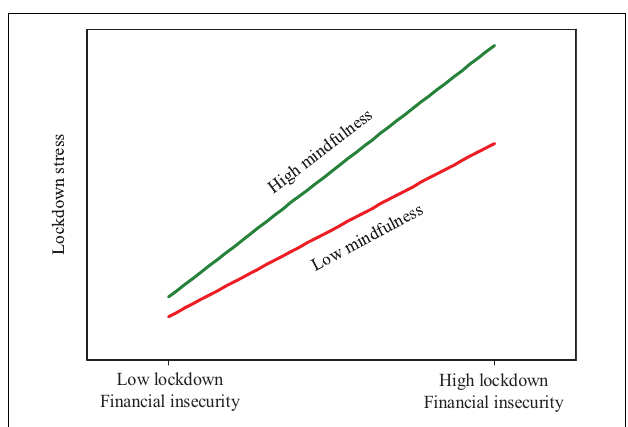
FIGURE 3 | A graphical illustration of moderation by